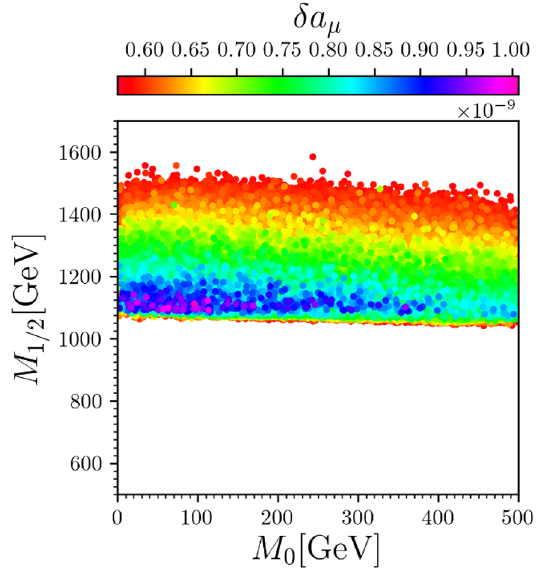
Figure 8 . The surviving samples in the parameter M (cid:14)a (cid:22) , the central value of SUSY (including Higgses) contribution to muon g-2. Samples with larger (cid:14)a (cid:22) are projected on top of the smaller ones.